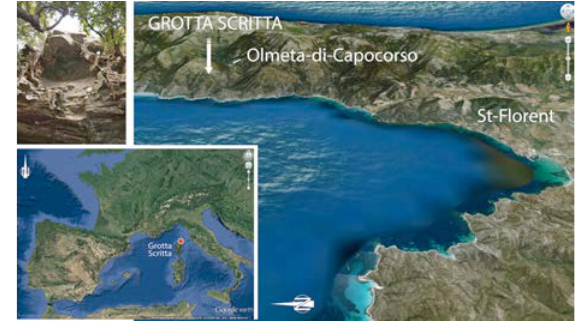
Figure 1. Location of the Grotta Scritta (Olmeta-di- Capocorso, Corse, France) and focus towards the decorated dome (photo A.